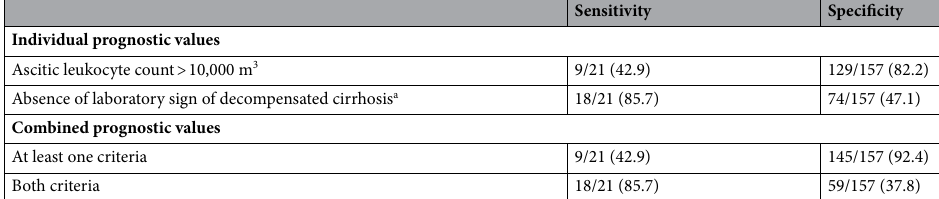
Table 3. Sensibility and specificity of independent factors of secondary peritonitis. Values are no./total no. (%) unless otherwise as indicated (calculated after handling missing values by multiple imputation). a Defined as platelet count < 150 G/L and/or bilirubin > 50 µmol/L and/or prothrombin time < 40%.